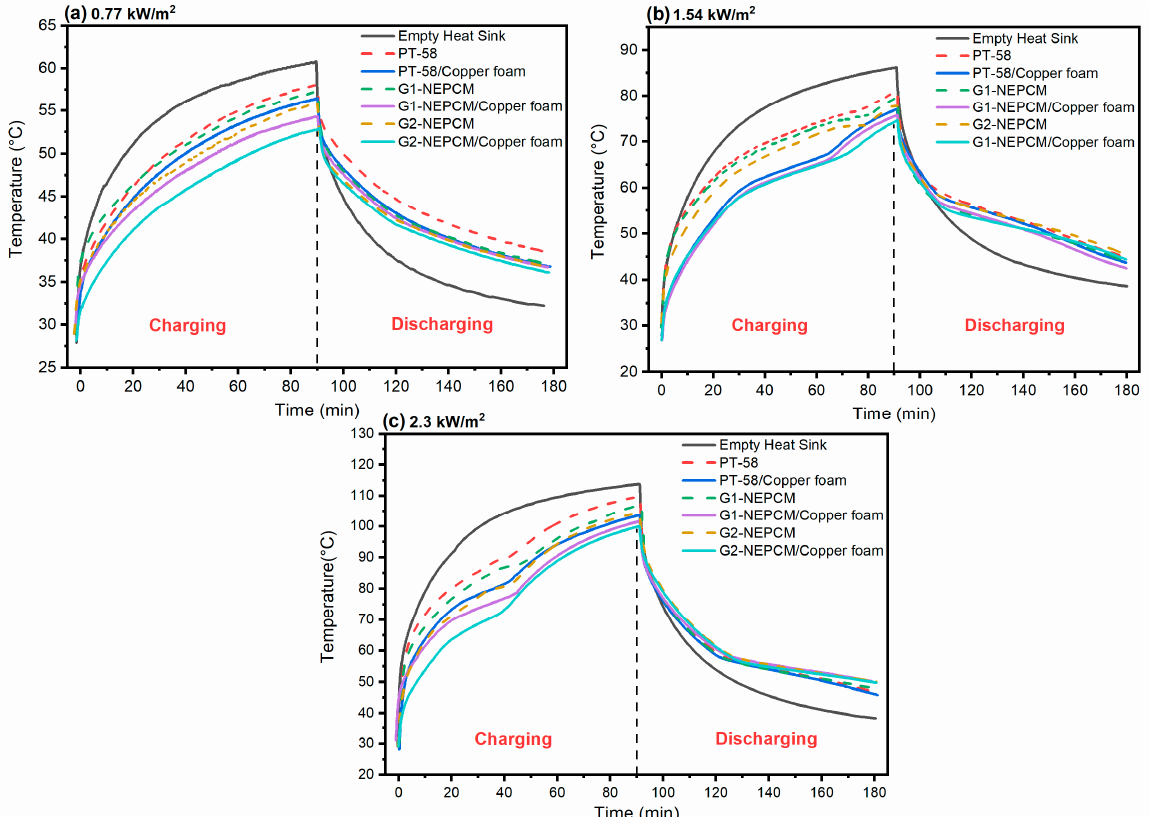
Figure 13. Charging and discharging analysis of various configurations of GNPs/PCM composites at heating inputs of: ( a ) 0.77 kW/m 2 ; ( b ) 1.54 kW/m 2 ; ( c ) 2.3 kW/m 2